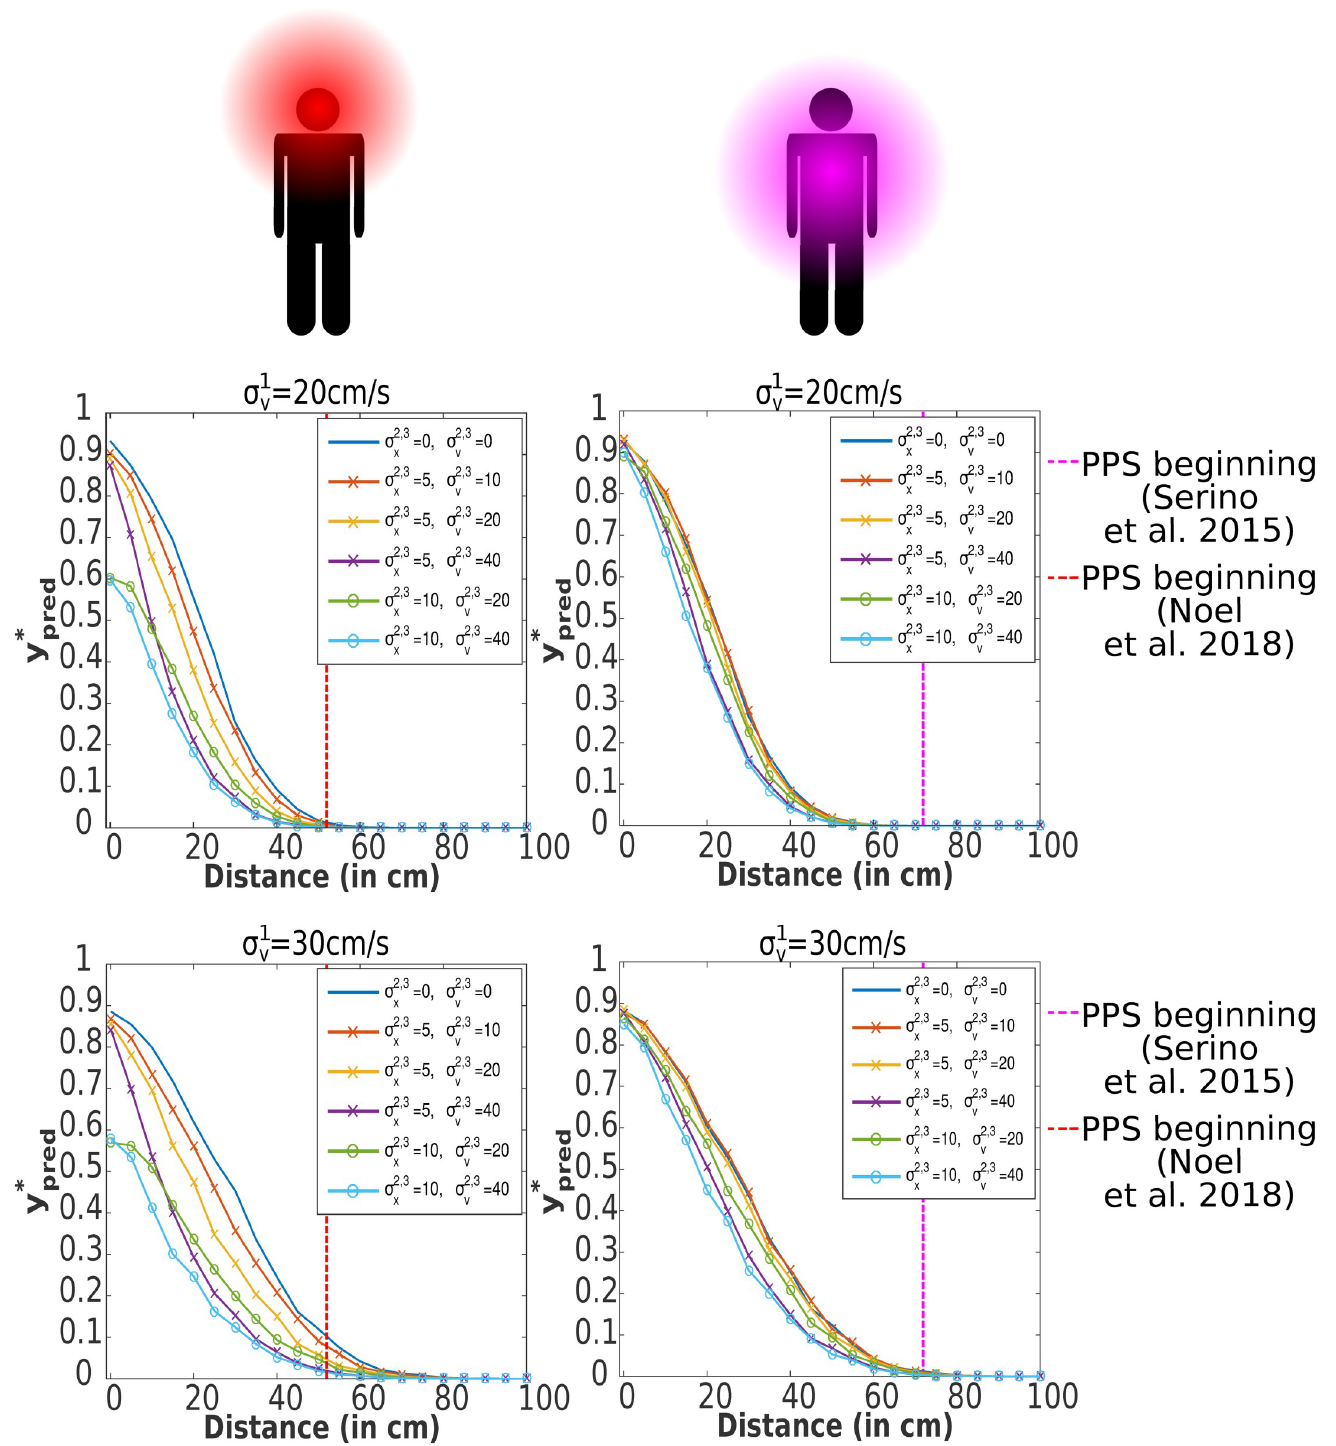
Fig 8. Modulation of PPS size by body part size in a 3D model (face and torso). For this experiment, 3D model was used (see Extension to 3D space). Dependency between distance of stimuli from body and the mean of 1000 impact predictions y � [25cm, 25cm]) and trunk (body part size [50cm, 50cm]). The object is moving along the x 1 axis ( x Position and velocity estimation uncertainty for the first dimension are s 1 uncertainties in the other two dimensions s 2 ; 3 The vertical dashed lines correspond to the estimations of the beginning of PPS from [14, 33]. See S4 Fig for a version with FN = FP = 1. https://doi.org/10.1371/journal.pcbi.1010464.g008 PLOS Computational Biology | https://doi.org/10.1371/journal.pcbi.1010464 September 14,